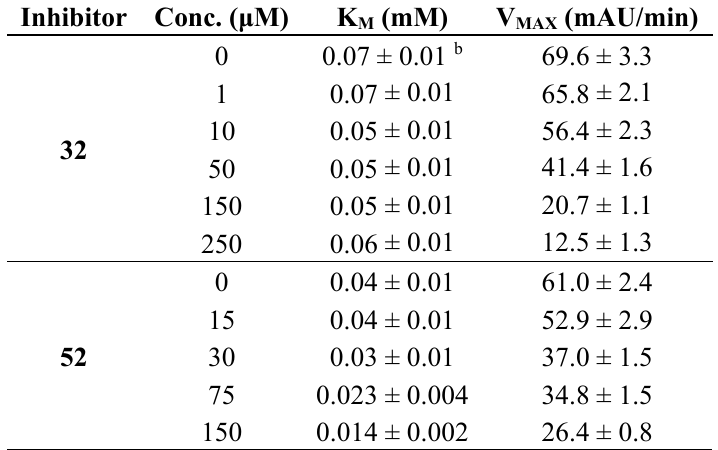
Figure 4. Michaelis-Menten kinetics of chromogenic substrate hydrolysis by human plasmin in the presence of sulfated flavonoid-quinazolinone heterodimer ( 32 ) ( A ) and flavonoid homodimer ( 52 ) ( B ). The initial rate of hydrolysis at various substrate concentrations was measured spectrophotometrically in pH 7.4 buffer at 37 °C. Solid lines represent nonlinear regressional fits to the data by the standard Michaelis-Menten equation to yield K M and V MAX . Table 2. Hydrolysis of Spectrozyme PL by plasmin in presence of NSGMs 32 and 52 .